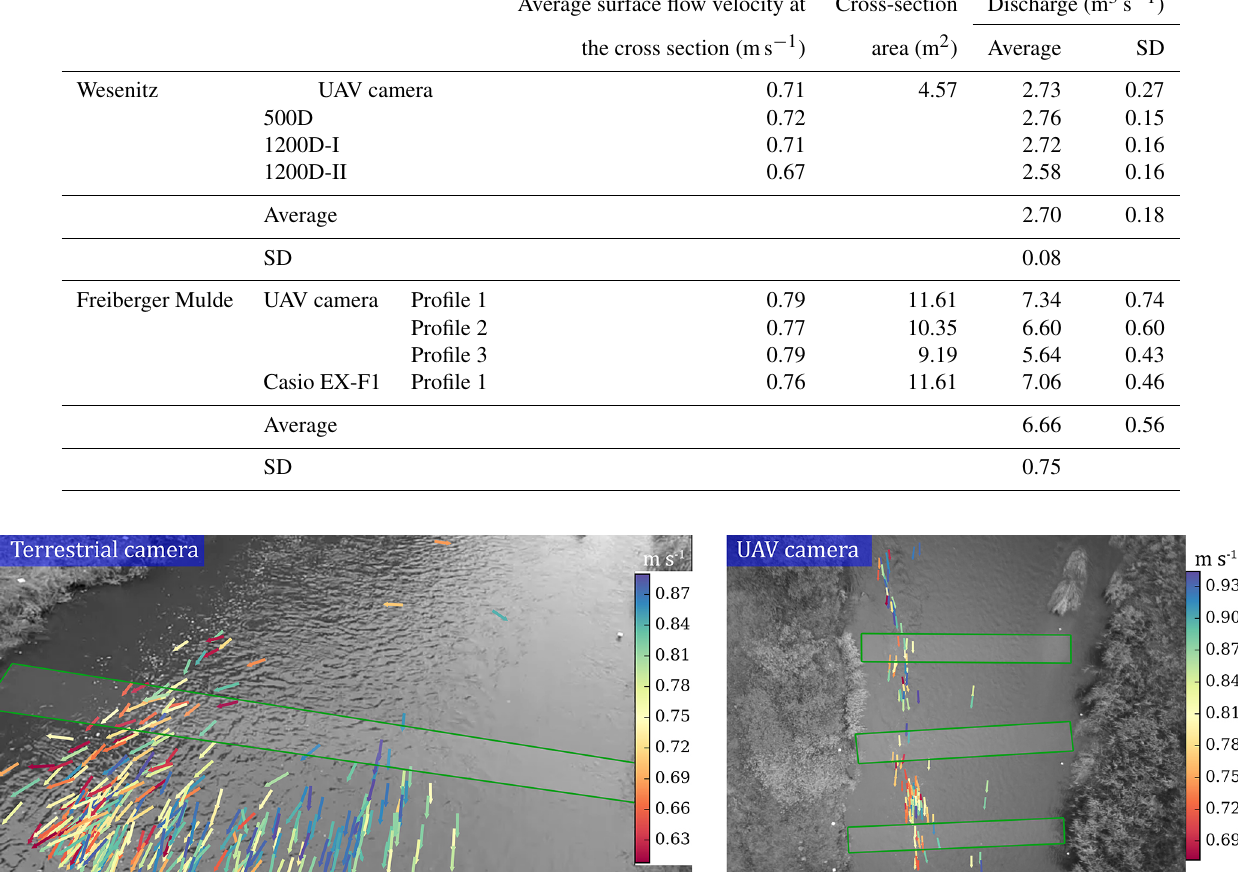
Figure 8. Flow velocities estimated at the Freiberger Mulde using video frames captured with a terrestrial camera and a camera on a UAV platform. Green border indicates area, in which image-based measurements are compared to ADCP